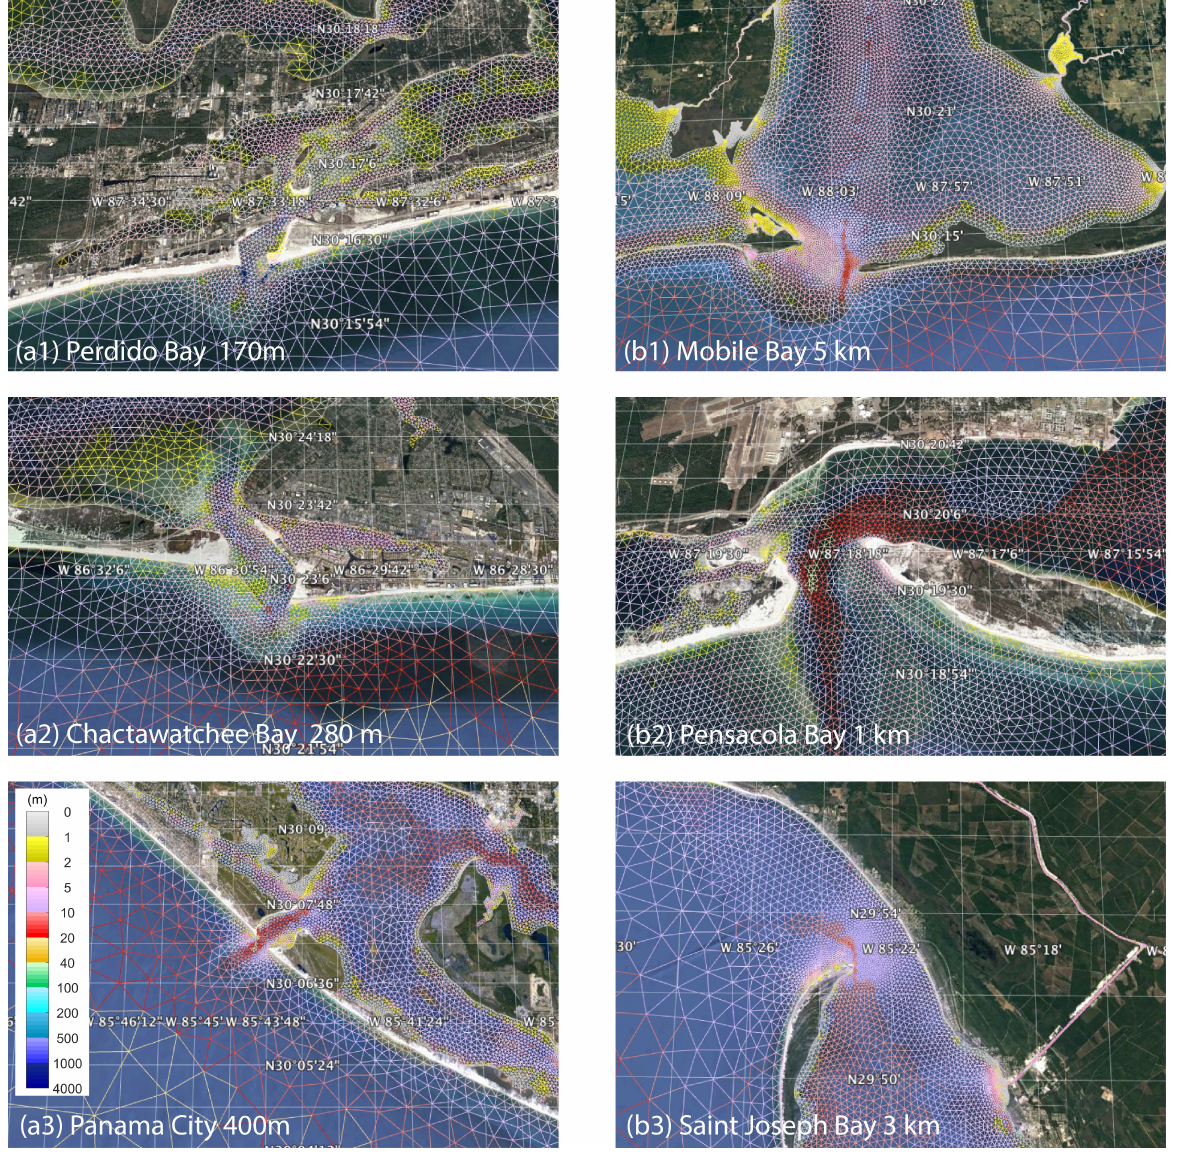
Figure 1. This is a figure, Schemes follow the same formatting. If there are multiple panels, they should Figure 4. High resolution applied at six inlets to Bays in VDatum region. ( a ) Three narrow inlets with be listed as: ( a ) Description of what is contained in the first panel. ( b ) Description of what is contained breakwaters. ( b ) Three nature inlets. See Figure 3 for locations. in the second panel. Figures should be placed in the main text near to the first time they are cited. A Table 2. Properties of the 2008 and the newly-developed tide model caption on a single line should be centered.